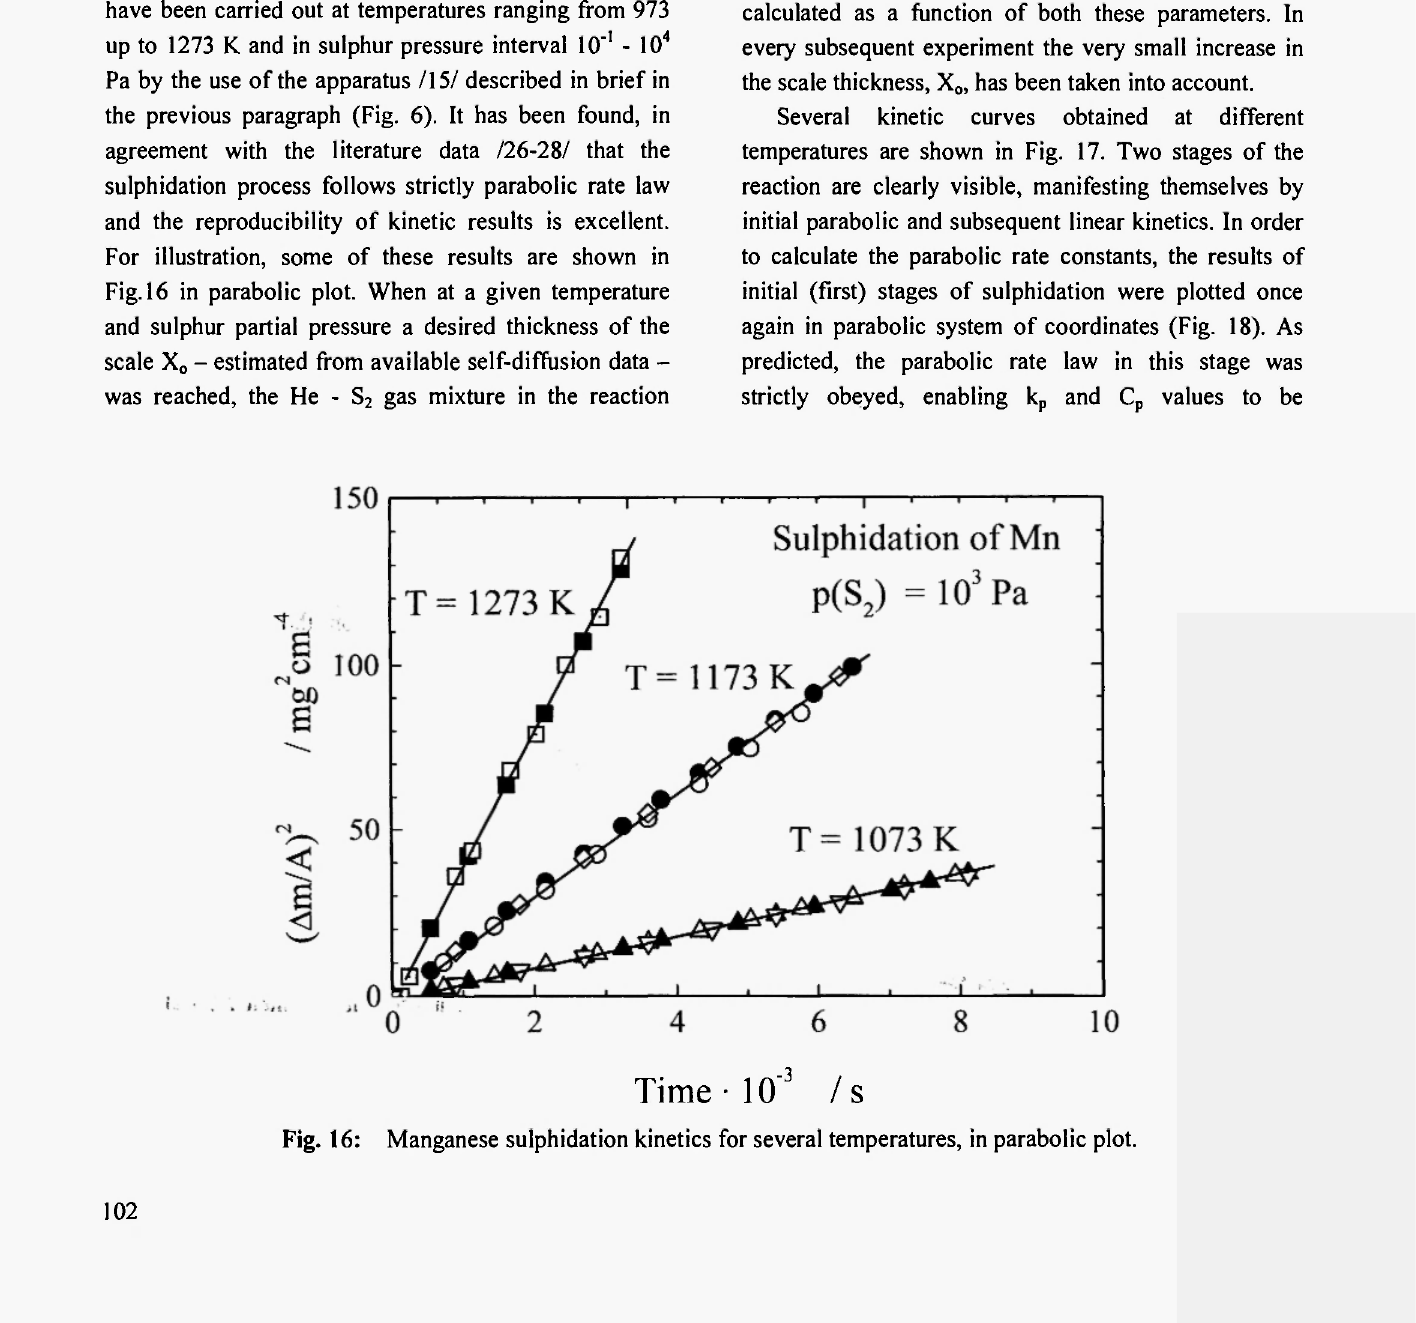
Fig. 16: Manganese sulphidation kinetics for several temperatures, in parabolic